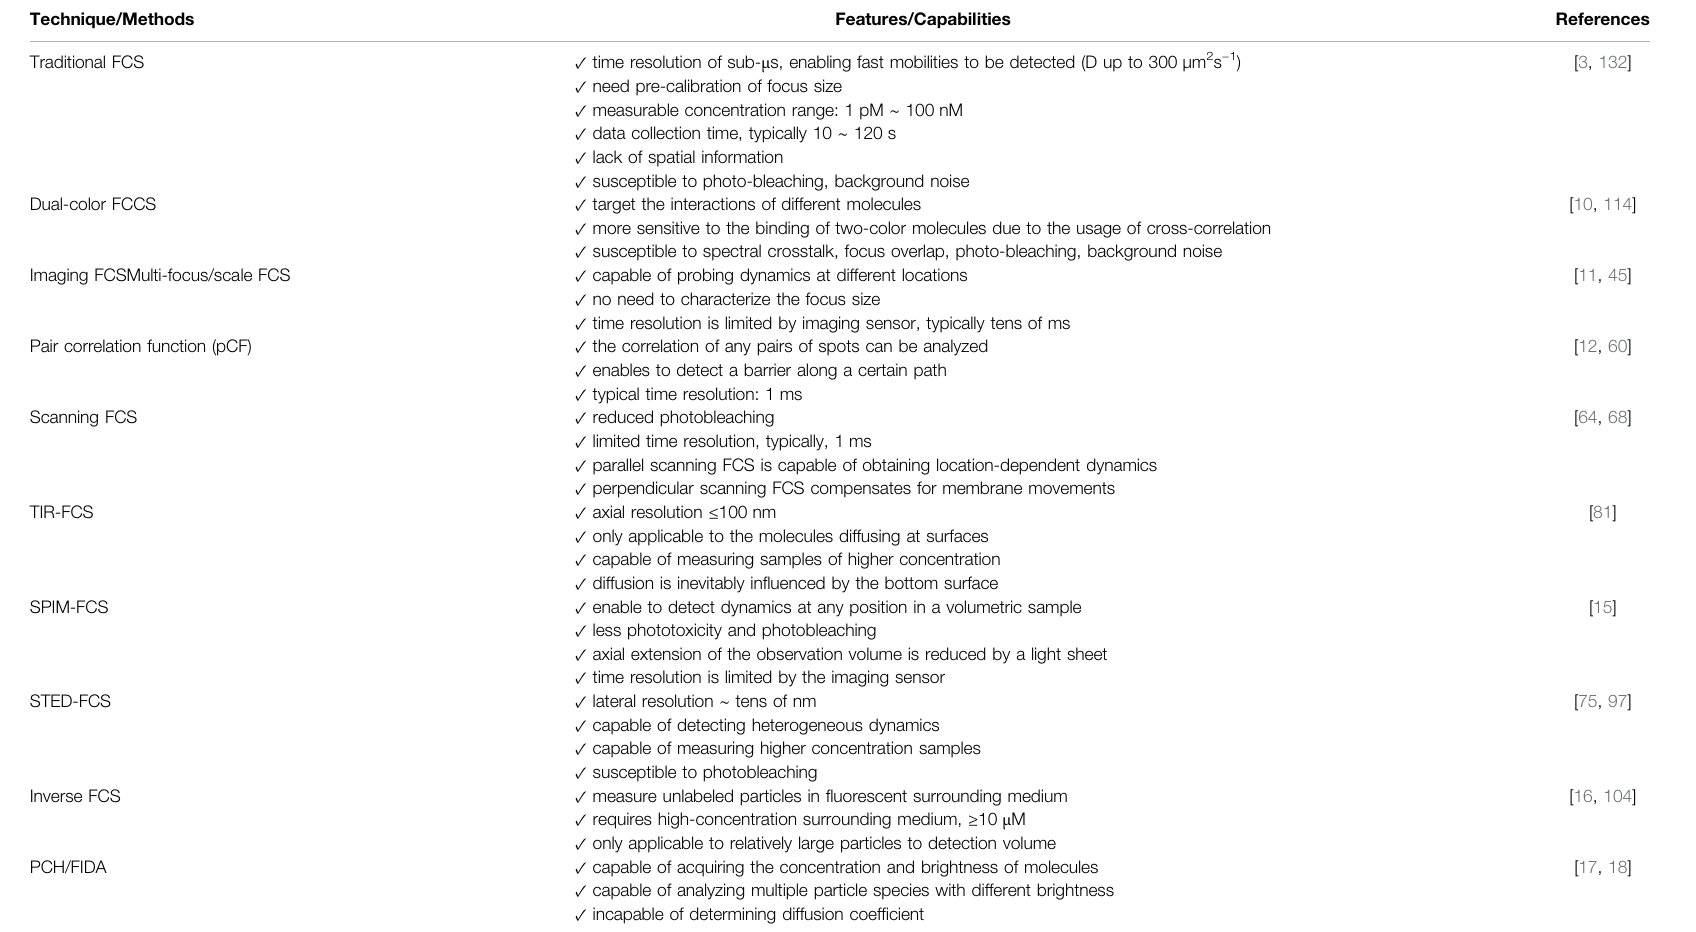
TABLE 1 | Overview of different FCS